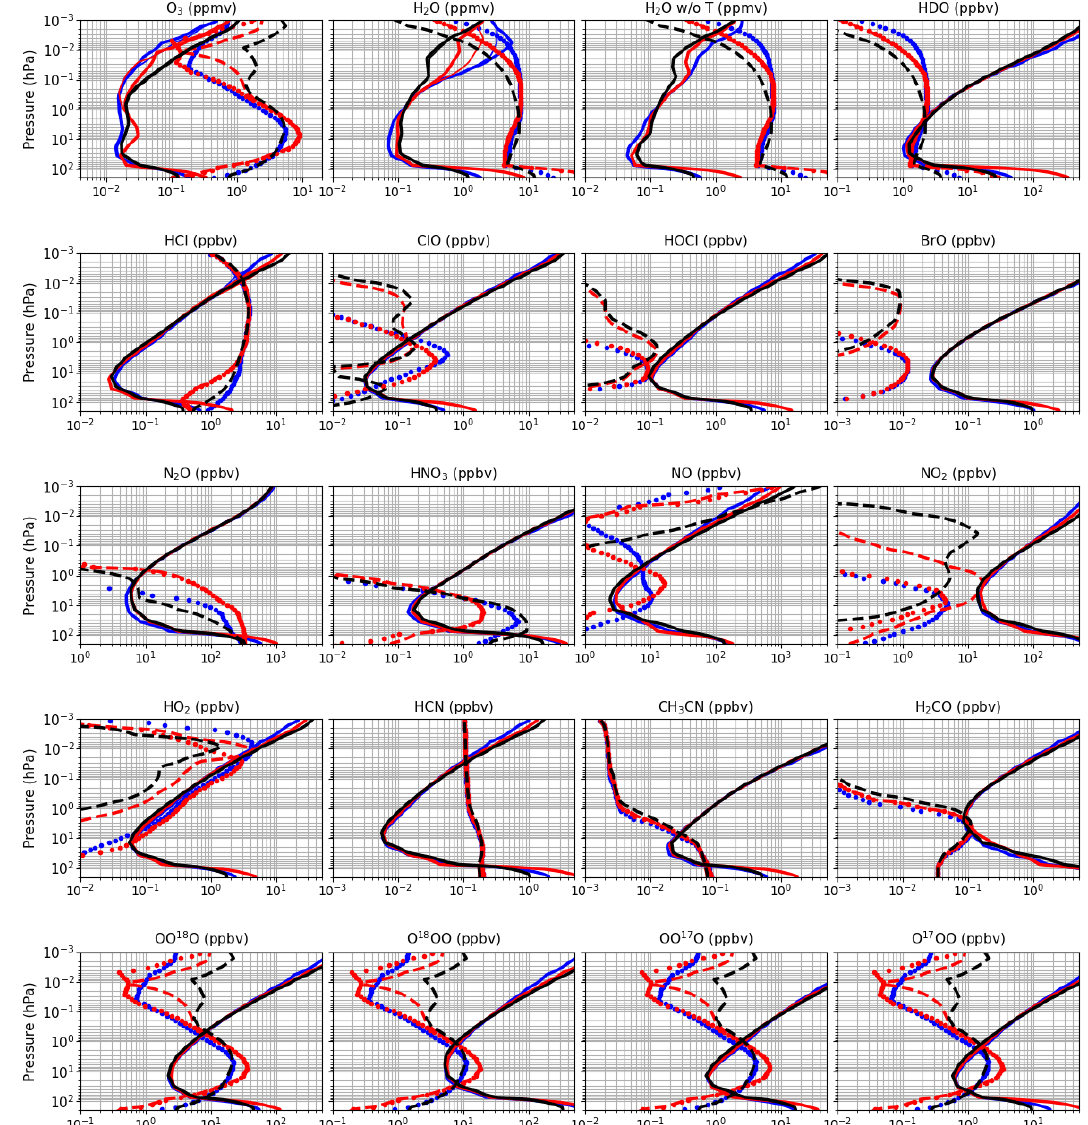
Figure 9. Single-scan retrieval precision (full lines), nighttime VMR (dashed lines) and daytime VMR (dotted lines) profiles. Profiles are shown at 80 ◦ S (blue line), Equator (red line) and 80 ◦ N (black line). The thick (thin) red full lines are nighttime (daytime) conditions. The H 2 O results without temperature retrieval are indicated by “w/o